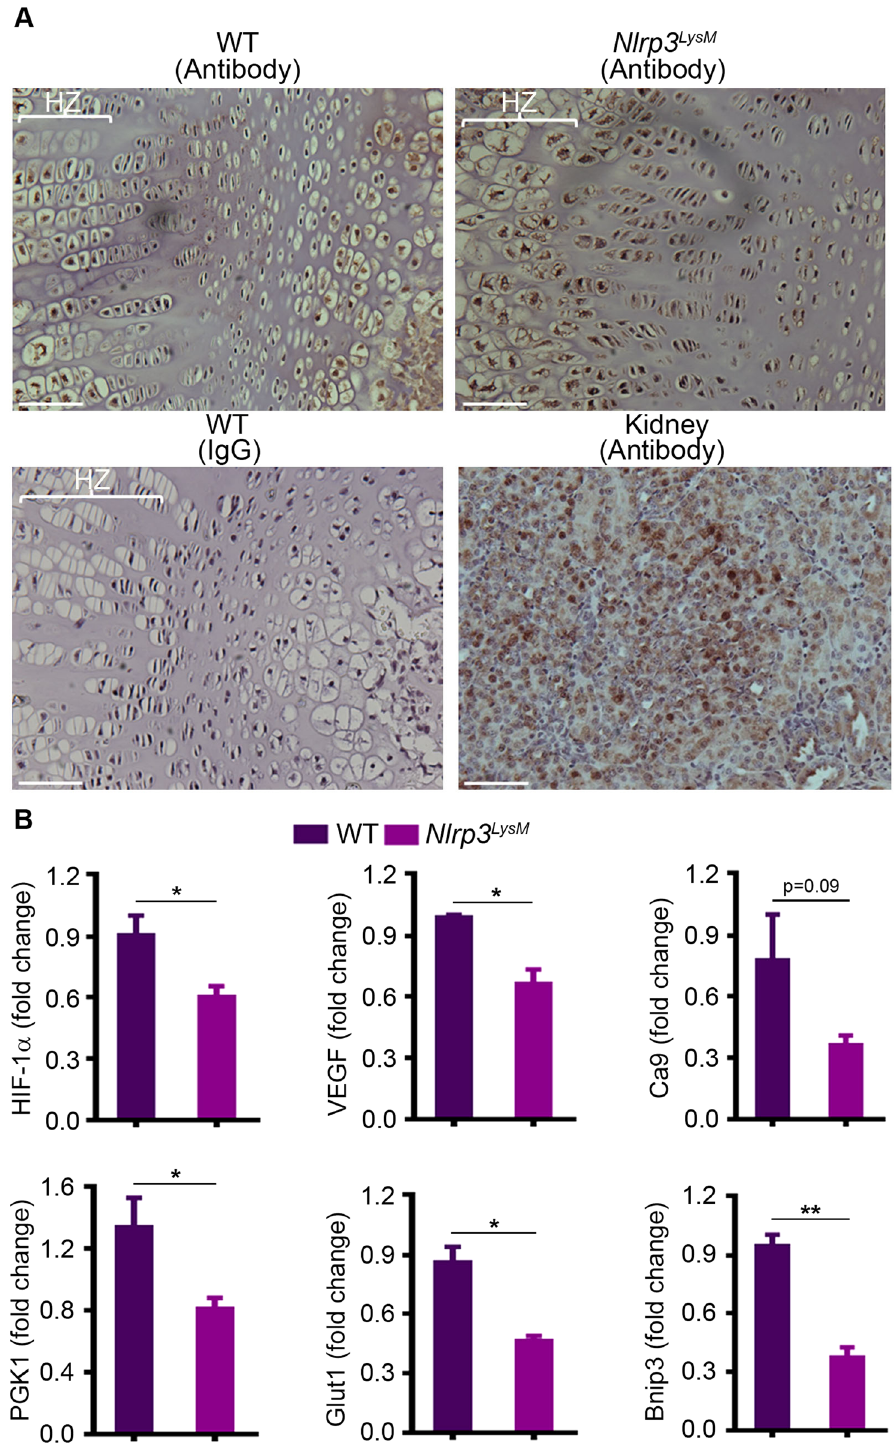
Figure 5. Activation of NLRP3 in myeloid cells impairs chondrocyte responses to hypoxia. ( A ) Femoral sections from 2-week-old WT or Nlrp3 LysM male mice injected with hydroxyprobe were stained with IgG or hydroxyprobe antibody. A specimen from renal medulla was used as a positive control. Staining is indicated by the brown color. HZ, hypertrophic zone. ( B ) qPCR analysis of mRNA isolated from mouse epiphyses. Quantitative data were obtained from 2–3 mice/genotype and expressed as the mean ± SEM. * P < 0.05; ** P <